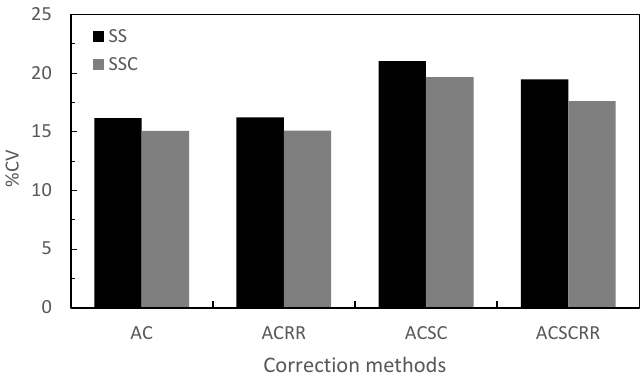
Figure 4. Relationship between %CV and correction methods among scan modes.